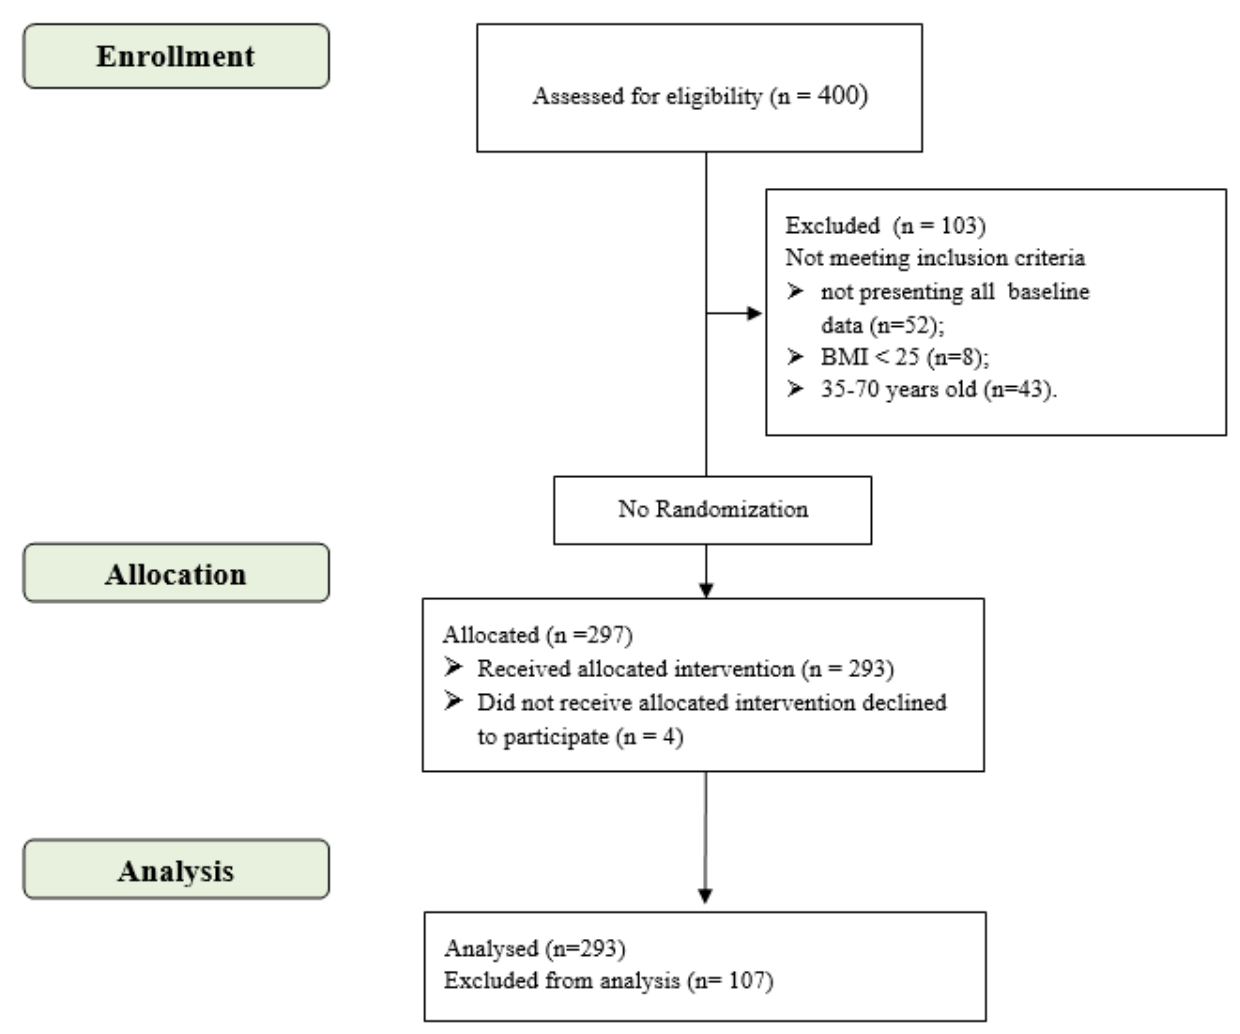
Figure 1. CONSORT flow diagram (adapted from CONSORT 2010 flow diagram).